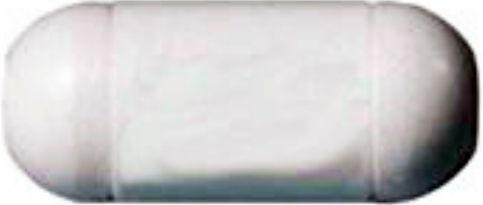
Figure 1. PillCam patency capsule.